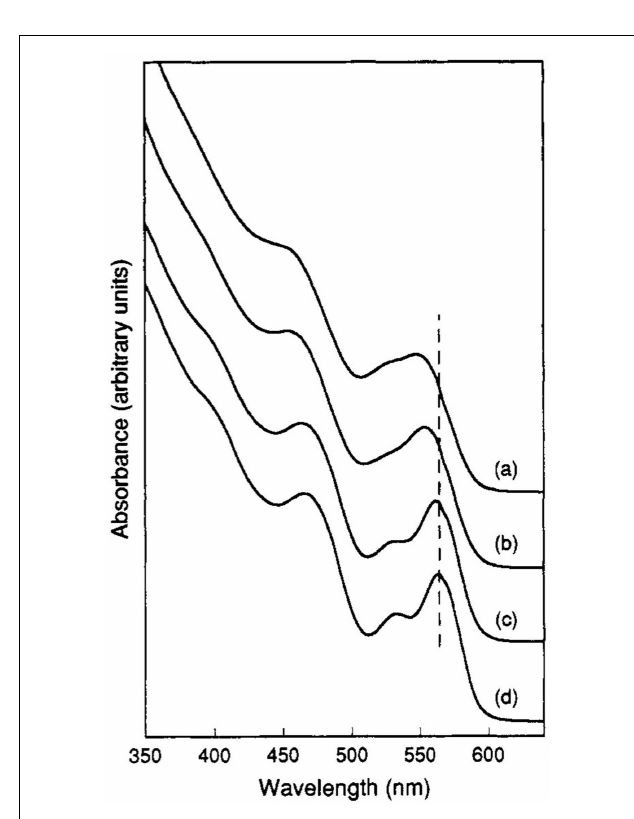
FIGURE 10 | Room temperature optical absorption spectra of CdSe nanocrystallites dispersed in hexane and ranging in size from ~12 to ~115Å (Murray et al., 1993)